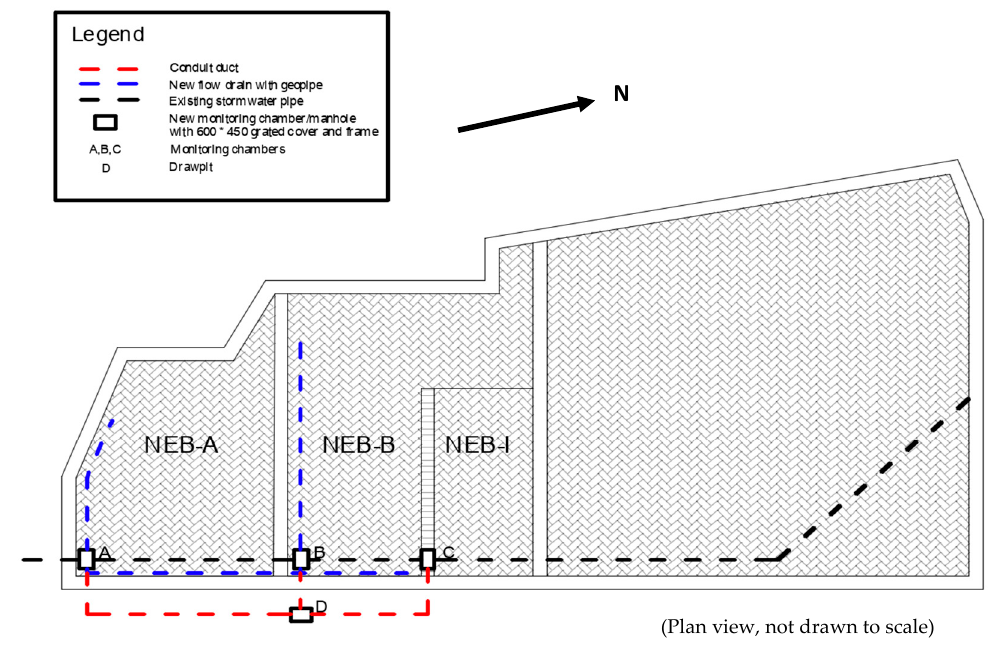
Figure 4. Schematic plan of the New Engineering Building (NEB) parking lot showing the drainage system and monitoring chambers [18].